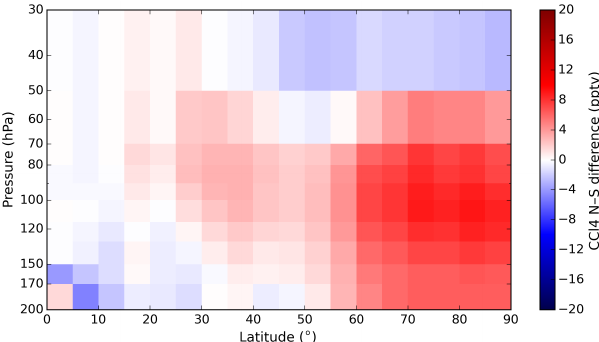
Figure 6. Average north–south CCl 4 VMR differences versus lat- itude and pressure. The average period includes MIPAS measure- ments from 1 April 2005 to 31 March